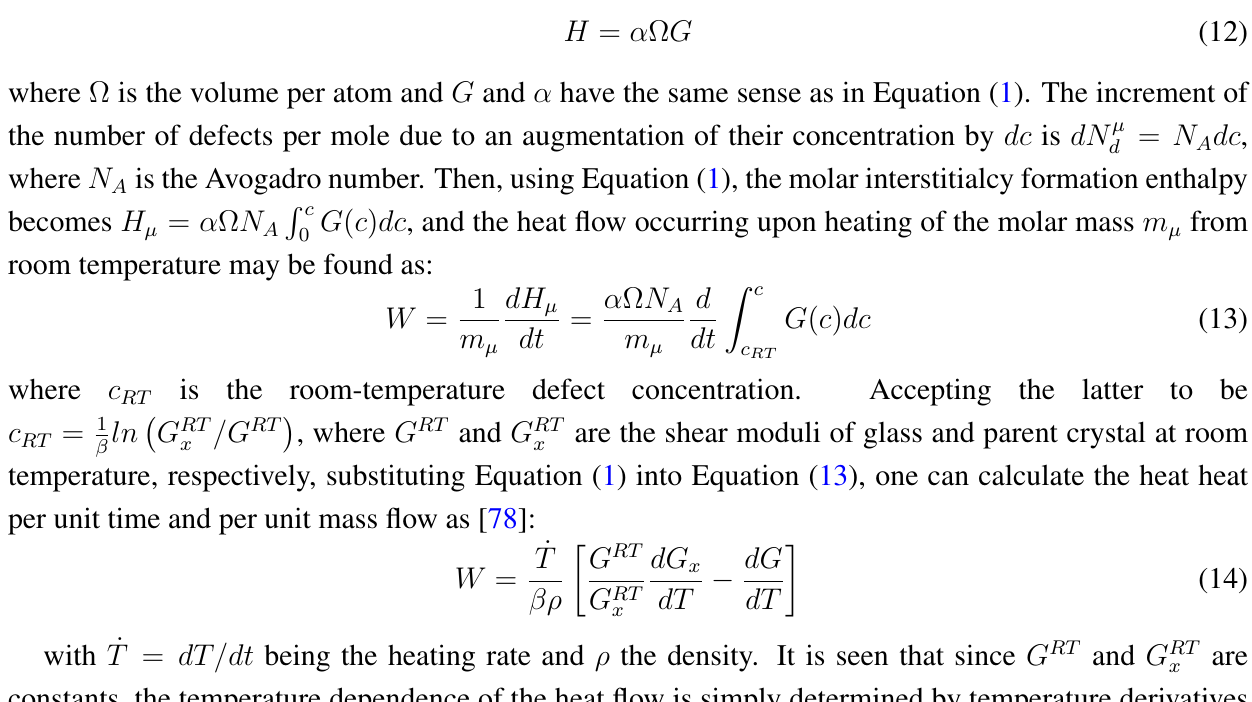
Cu Al , (cid:13) and (cid:13) , for temperature ranges where 46 46 8 ini rel ≈ (cid:13) ≈ 1 ini rel